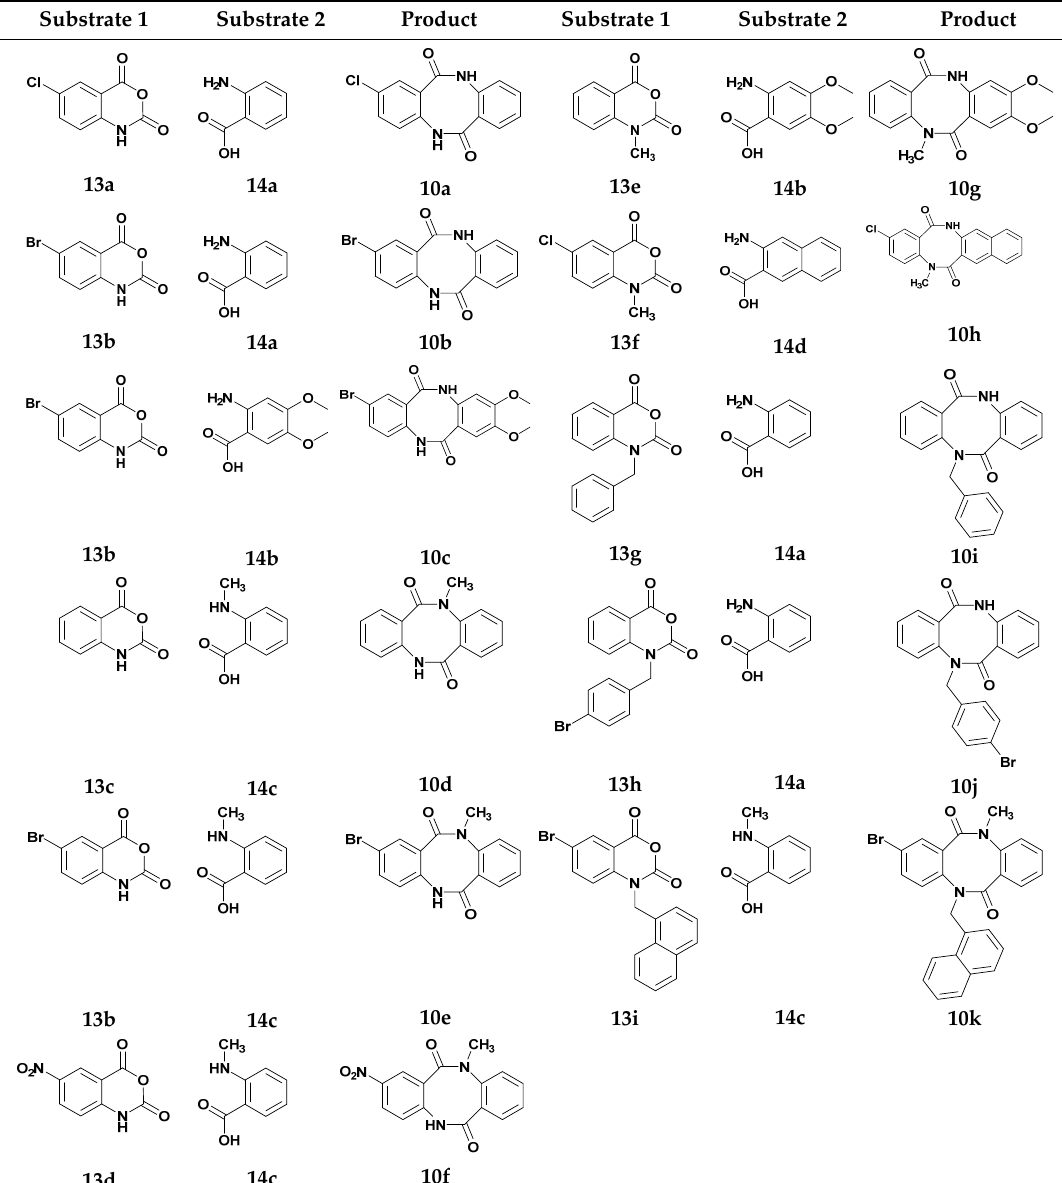
Table 1. Synthesized compounds.